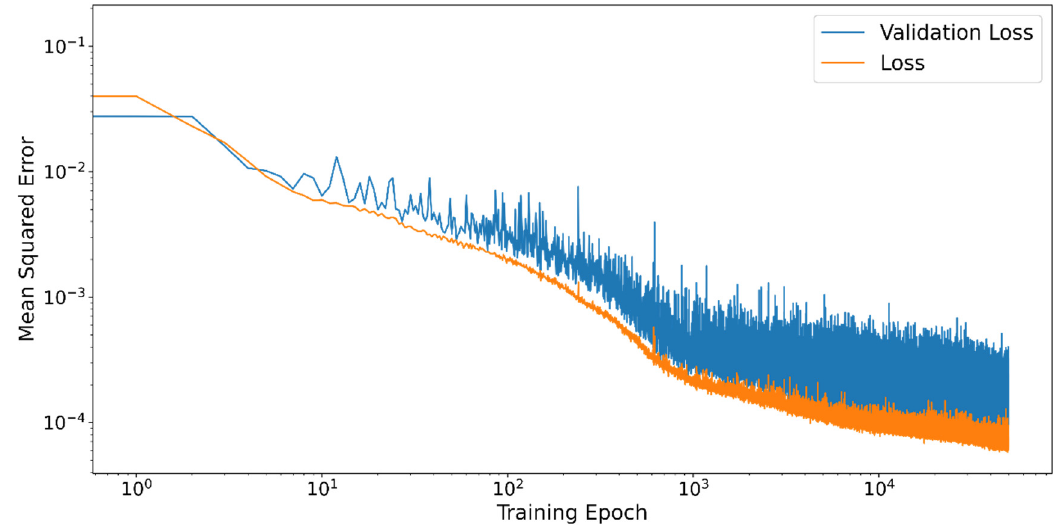
Figure 5. Training behavior of the neural network for each training epoch. The neural network is evaluated by the objective function for the training data (Loss) and the validation data (Validation Loss).